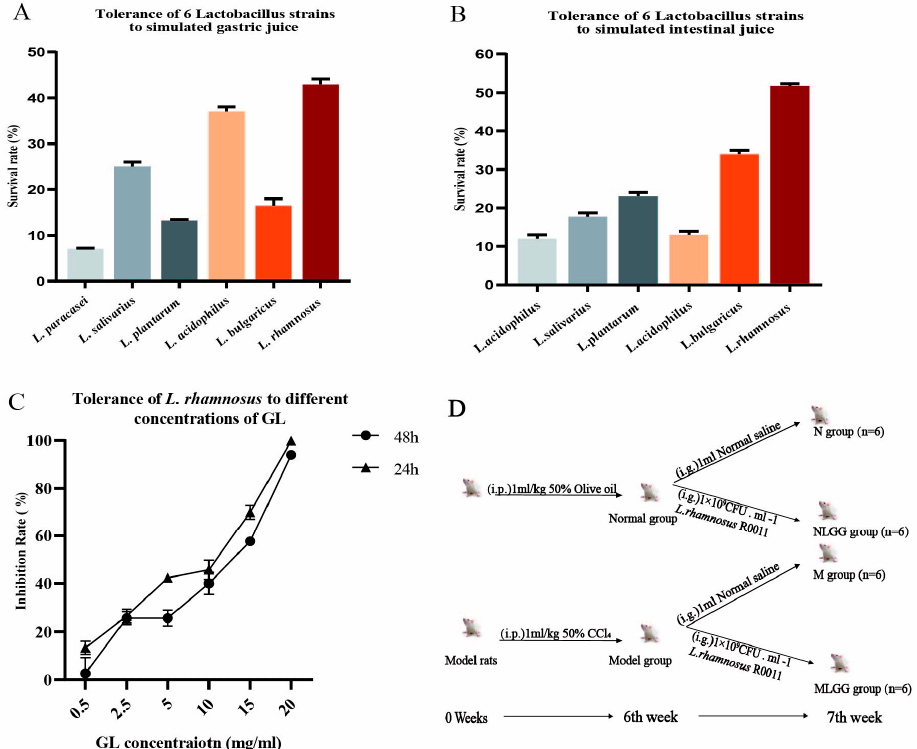
Figure 1. In vitro screening of Lactobacillus tolerance in the gastrointestinal environment and animal experimental protocol. ( A ) Tolerance of six Lactobacillus species in simulated gastric juice. ( B ) Toler- ance of six Lactobacillus species in simulated intestinal fluids. ( C ) Tolerance of L. rhamnosus R0011 at different concentrations of GL. ( D ) Animal experimental design and protocols for the four groups of rats, the normal group (N group), the normal group supplemented with L. rhamnosus R0011 (NLGG group), CCl4 -induced chronic liver injury model (M group), and the model group supplemented with L. rhamnosus R0011 (MLGG group).